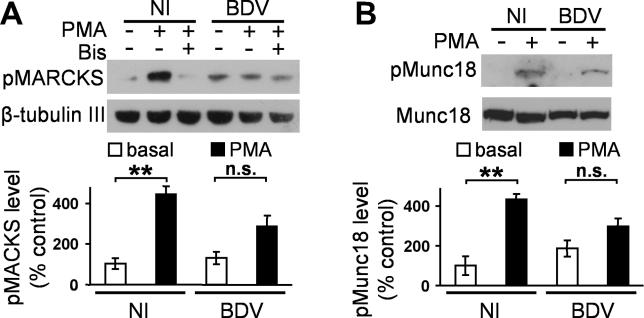
Analysis of PKC Signaling in NI and BDV-Infected NeuronsWestern blot analyses of (A) MARCKS and (B) Munc18 phosphorylation by PKC. β-Tubulin III and total Munc18 were used to normalize expression. Results are representative of three to five independent experiments. Double asterisks (**) indicate p < 0.01. n.s., not significant, using unpaired t test.